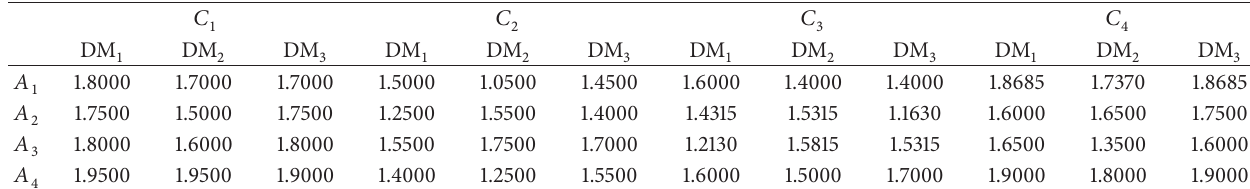
Table 4: The supports for each HFE from other HFEs.